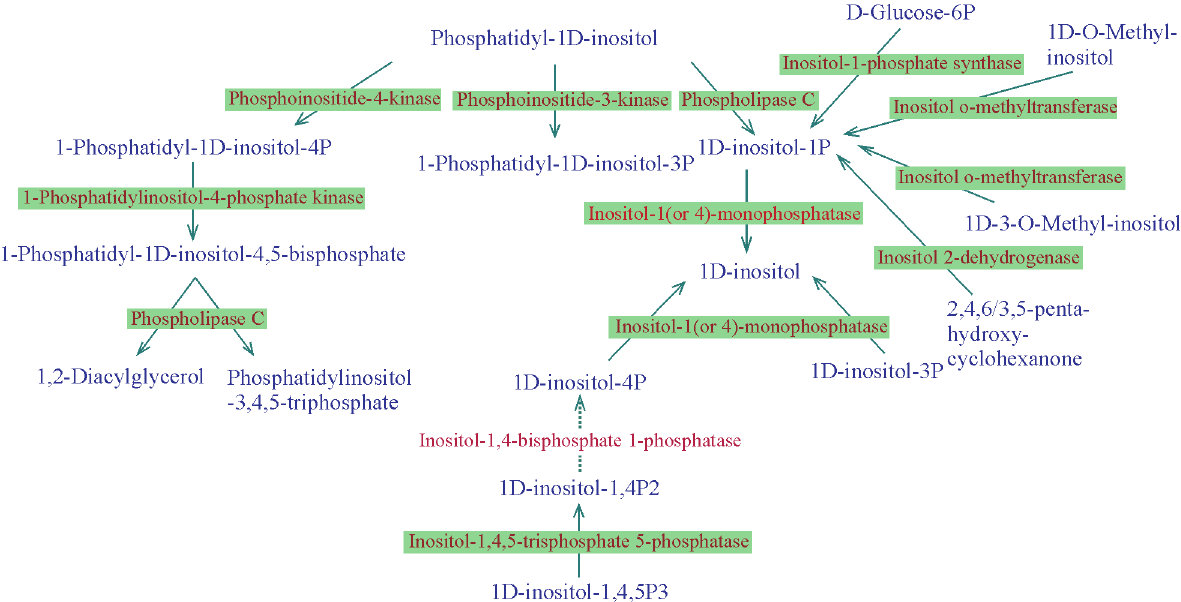
Figure 2 - Inositol metabolism in sugarcane. The enzymes for which clusters have been found in sugarcane are highlighted in green. Also shown are the inositol intermediate compounds predicted to